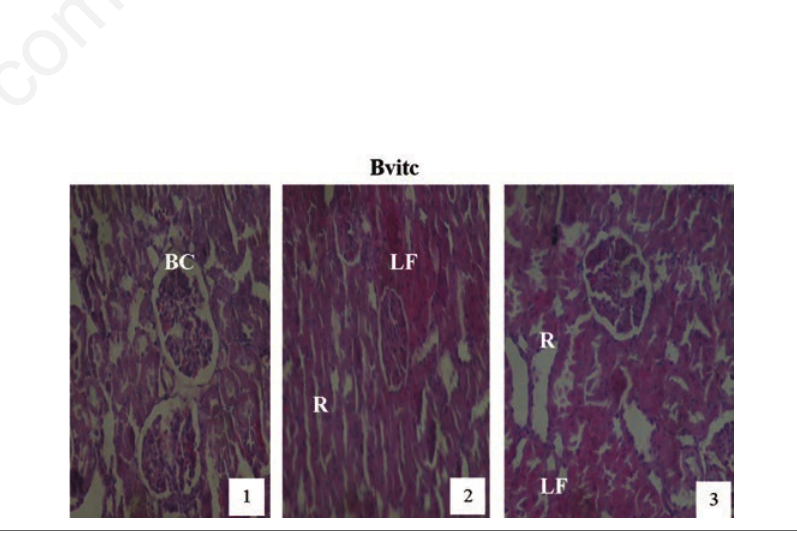
Figure 10. Hematoxylin and eosin staining after administration of 6 mg/kg of paraquat rep- resenting test subgroups maintained with no vitamin C medicated drinking water for a peri- od of 3 months (original magnification 400X). The slide at month (1) is showing a picture of shrunken Bowman’s capsules (BC) and swollen glomeruli (G) progressing to massive renal vascular congestion (R) and degeneration (DCT) at month (2). At month (3) the picture indicated advanced renal tubular atrophy (VC), interlobular vacuolation with glomerular (G) and tubular degeneration. Changes increased in an exposure time dependent manner.